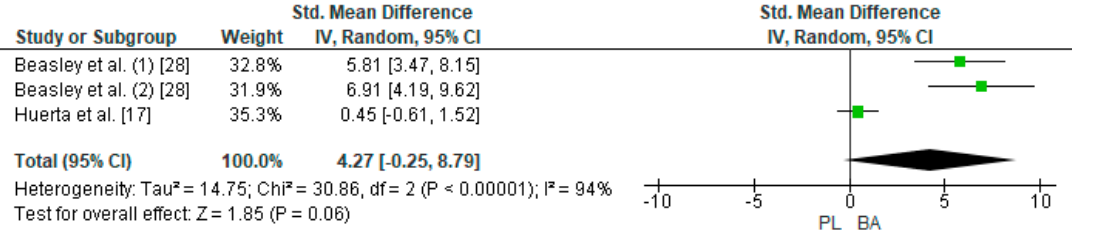
Figure 7. Forest plot comparing the effect of BA on Limited Distance Test. BA: beta ‐ alanine; PL: placebo.